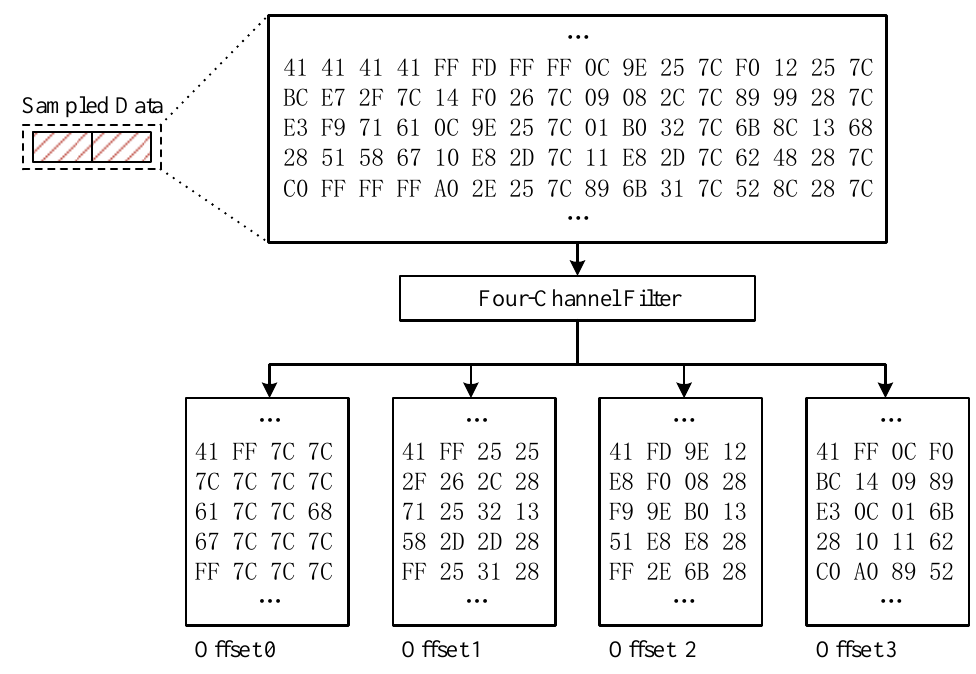
Figure 4. Channel decomposition before time-series feature